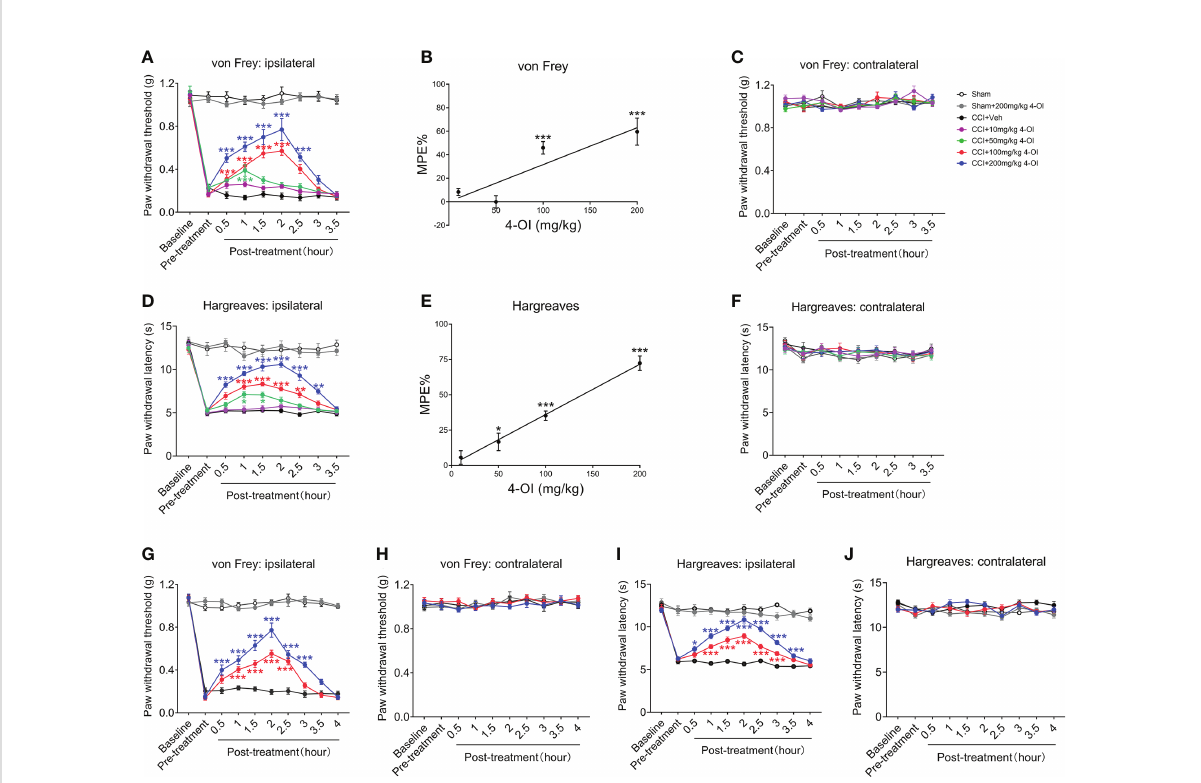
FIGURE 3 Intraperitoneal injection of 4-OI suppressed the neuropathic pain of the both sexes CCI mice. (A) The effect of systemic application of 4-OI on the PWT of ipsilateral hind paw in male CCI mice at 14th days post injury. (B) The maximum possible effect (MPE) of PWT at 1 hour post 4-OI was calculated. (C) The effect of 4-OI on the PWT of contralateral hind paw. (D) The effect of systemic application of 4-OI on the PWL of ipsilateral hind paw in male CCI mice at 14th days post injury. (E) The MPE of PWL at 1 hour post 4-OI was calculated. (F) The effect of 4-OI on the PWL of contralateral hind paw. (G) The effect of systemic application of 4-OI on the PWT of the ipsilateral hind paw in female CCI mice at 14th days post-injury. (H) The effect of 4-OI on the PWT of the contralateral hind paw. (I) The effect of systemic application of 4-OI on the PWL of the ipsilateral hind paw in female CCI mice at 14th days post-injury. (J) The effect of 4-OI on the PWL of the contralateral hind paw. Data are presented as mean ± SEM. *** p <0.001, ** p <0.01, * p <0.05 vs. CCI + Veh, followed by two-way ANOVA (A, D, G, I) and one-way ANOVA (B, E) with Tukey ’ s and Dunnett ’ s multiple comparisons test (n =